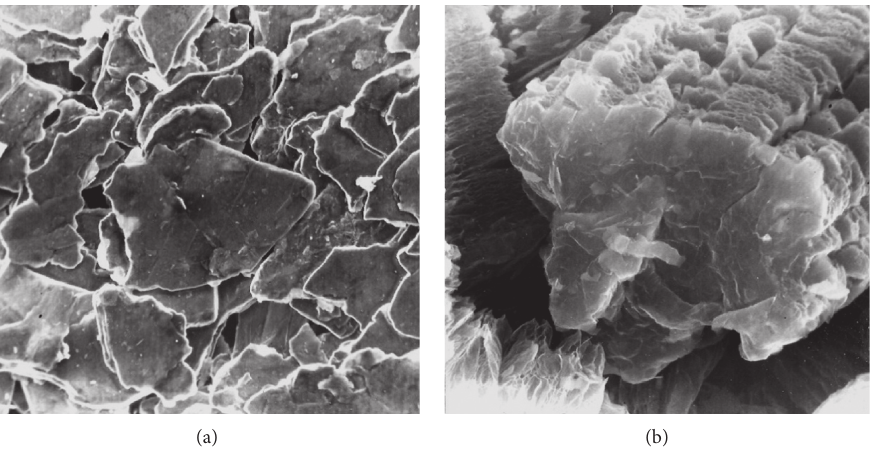
Figure 15: The layered compound of graphite in the initial state (a) and after the thermal shock (b) ( ×